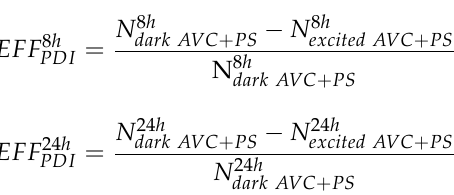
before (black line) and after laser irradiation (red and green line, respectively) in range of 3600–2800 cm − 1 , corresponding to stretching vibrations of OH, NH, and CH groups (left) and in range of 1800–1500 cm − 1 dominated by n (C = O) and δ (NH) bands (right); (B) The representative ATR-FTIR spectra of AVC material (black line), AVC-Ce6 (green line), and AVC-Pheo (red line) photosensitizers with (C) zoomed spectra in the range of 1800–1500 cm − 1 ; Figure S2 . The ATR-FTIR spectra of Aristoflex™ AVC before (black line) and after laser irradiation (grey line); Figure S3. The boxplot represents the variation of the averaged RI of E. coli and S. aureus cells depending on the material used: AVC, AVC-Ce6, AVC-Pheo. The central mark indicates the median, and the bottom and top edges of the box indicate the 25th and 75th percentiles. The whiskers extend to the most extreme data points not considered outliers, and the outliers are plotted using the ‘+’ symbol.; Table S1 . The results of the ANOVA, where each of 6 groups represent the set of average RI of E. coli and S. aureus cells for each material: AVC, AVC+Ce6, AVC+Pheo (dark-controls); Table S2 . The results of the ANOVA of the averaged RI of set of 20 dividing and non-dividing E. coli and S. aureus cells on the surface of AVC+Ce6, AVC+Pheo materials